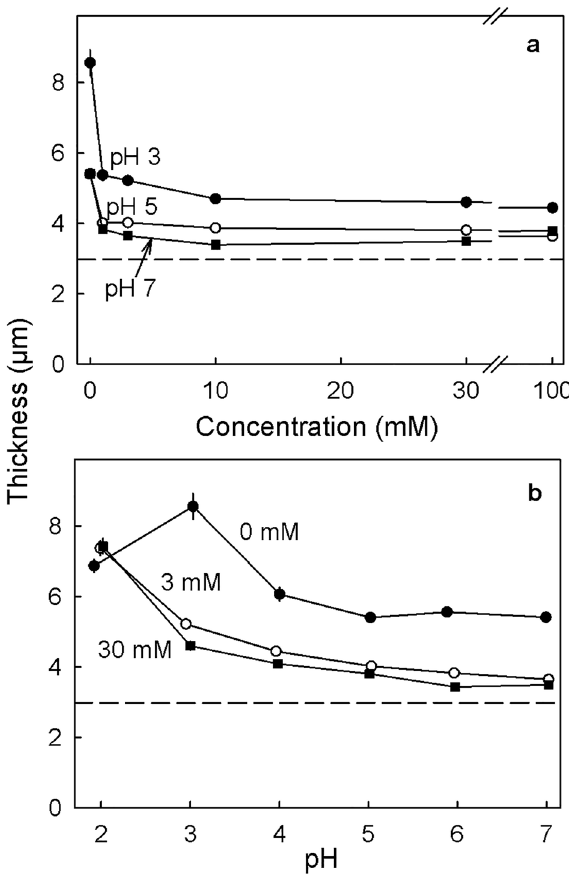
Figure 2. ( a ) Effect of the concentration of CaCl 2 at pH 3.0, pH 5.0 or pH 7.0 on the thickness of the anticlinal cell walls of excised epidermal segments (ES) of mature ‘Burlat’ sweet cherry fruit. ( b ) Effect of pH at CaCl 2 concentrations of 0, 3 and 30 mM. All ES were treated with a freeze/thaw cycle to release turgor followed by an incubation in the respective solution for 48 h. All solutions were buffered with 10 mM MES. The dashed horizontal line indicates the cell wall thickness in the native state, i.e., before the release of